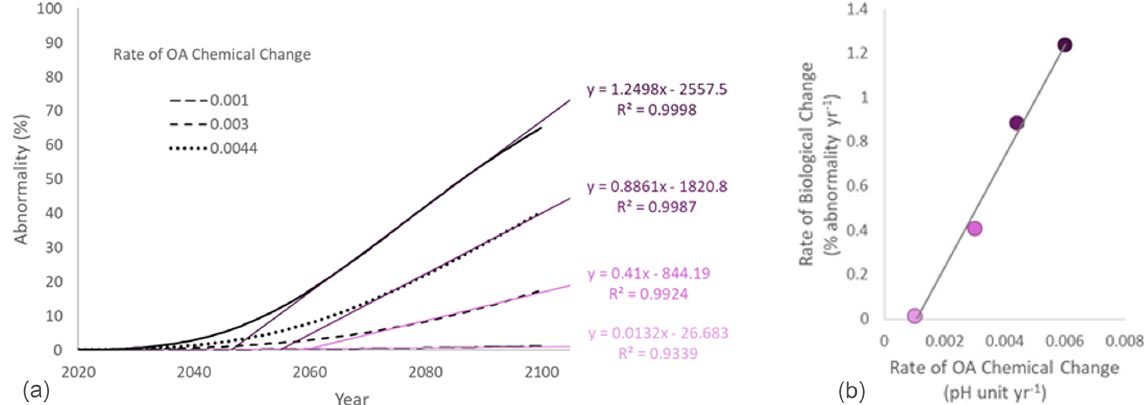
Figure 4. (a) Projection of larval abnormality under different scenarios of rate of chemical change. The rate of biological change was estimated for each scenario as the coefficient of the significant regression between time and abnormality (%) over the linear phase of the curve. (b) Relationship between the chemical and the biological rates of